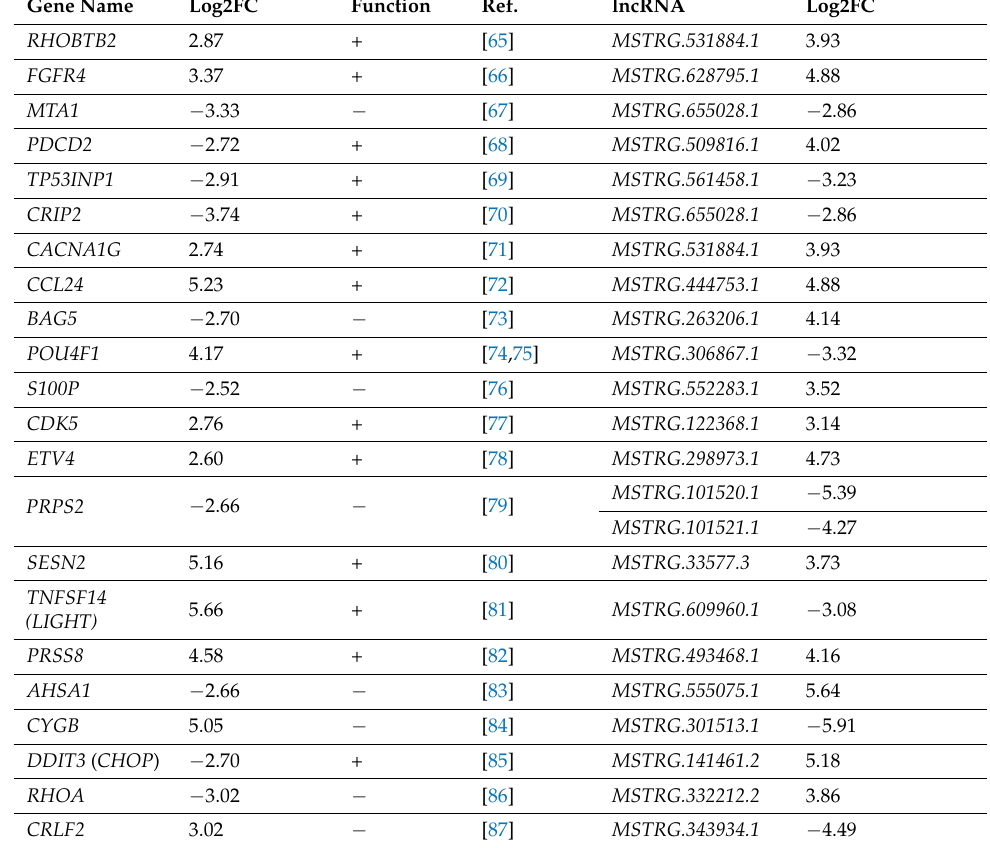
Table 2. Apoptosis-related mRNAs and their corresponding lncRNAs that were significantly differentially expressed between fresh and frozen-thawed giant panda sperm. “ − ”